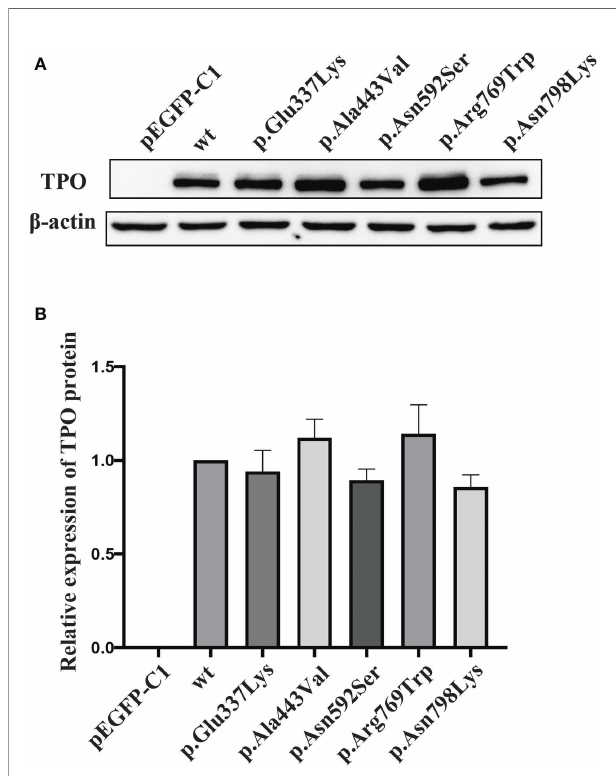
FIGURE 4 | Protein expression level of wild-type and mutant TPOs. (A) Western blotting results of wild-type and mutant TPO proteins. (B) Relative expression level of tested proteins in relation to wild-type TPO protein. wt, wild-type.